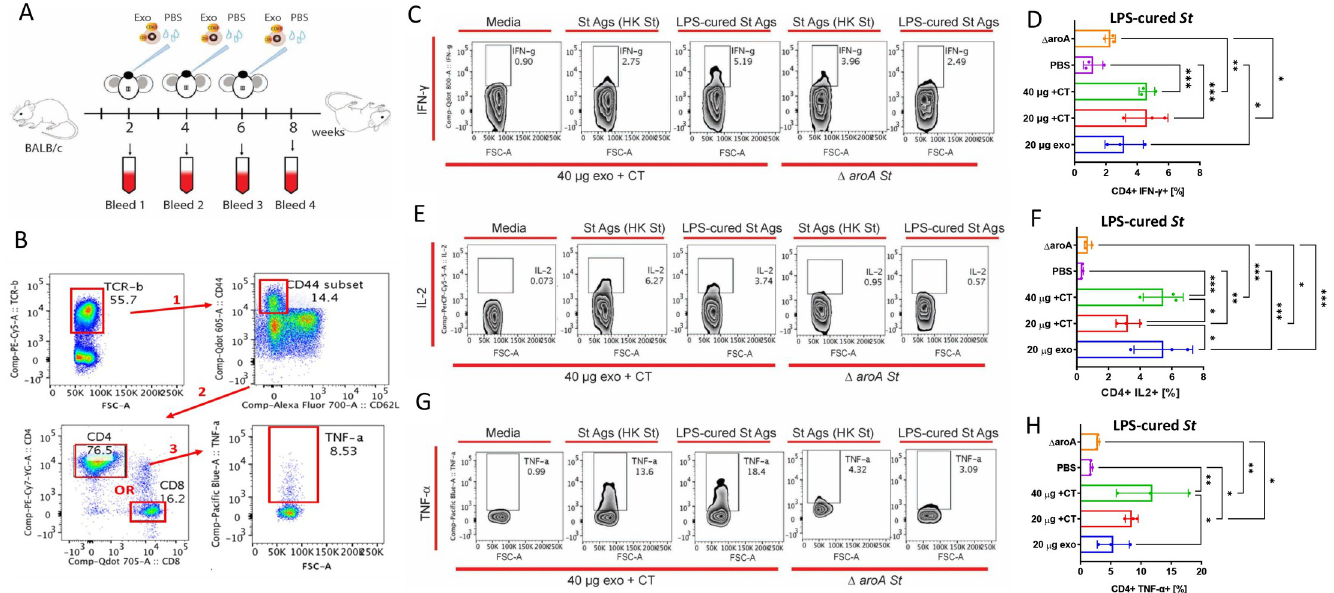
Fig 6. Exosomes derived from Salmonella -infected murine macrophages stimulate CD4 + T lymphocytes in vivo . (A). A schematic of the experiment. Mice (5/ group) were IN immunized with 20- μ g or 40- μ g doses of exosomes derived from Salmonella -infected macrophages (Exo) in the presence or absence of cholera toxin adjuvant (CT) or MPL adjuvant. Other mice were immunized with live Δ aroA S . Typhimurium vaccine ( χ 9909). Two booster immunizations were administered in 2-week increments . (B). Splenocytes obtained from mice administered with exosomes, PBS, or Δ aroA S . Typhimurium were re-stimulated with media (control), whole Salmonella antigens, or LPS-cured Salmonella antigens [see (A) for regimen]. Splenocytes were stained as described in the individual figures below. FACS analyzed pools of indicated CD4+ or CD8+ cells producing specific cytokines in the following manner: memory T-lymphocytes were distinguished from na ï ve T-lymphocytes by gating for effector T-lymphocyte phenotype (TCR- β + CD44 + CD62L - ). Next, effector T-lymphocytes are characterized phenotypically by high expression levels of CD44+ hi and CD62 lo, in which we subsequently gated for CD4+ (or CD8+) specific T-lymphocytes and then CD4+ (or CD8+) T-lymphocytes secreting appropriate cytokines as indicated on figures. (C)-(H). Mice were exposed to conditions indicated above (A) . FACS analysis (B) of CD4+ cells was performed on splenic mononuclear cells treated with heat-killed Salmonella Ags, LPS-cured Salmonella Ags, or media (control). Cells were stained intracellularly for IFN- γ (C, D) , IL-2 (E, F) , and TNF- α (G, H) . Zebra plots show individual analyses ( C, E, F ), where the antigen used for cell re-stimulation is indicated on the top of the graphs while the source of splenocytes is indicated on the bottom of the figures. (D), (F), (H). The summary graphs showing the percentage of CD4+ cells that express IFN- γ , IL-2, or TNF- α upon restimulation with Salmonella Ags devoid of LPS. Data on graphs are represented as mean ± SD. The p -values were determined by ANOVA and indicated as follows (n = 3): * p � 0.05; ** p � 0.01; *** p � 0.001; **** p � 0.0001.